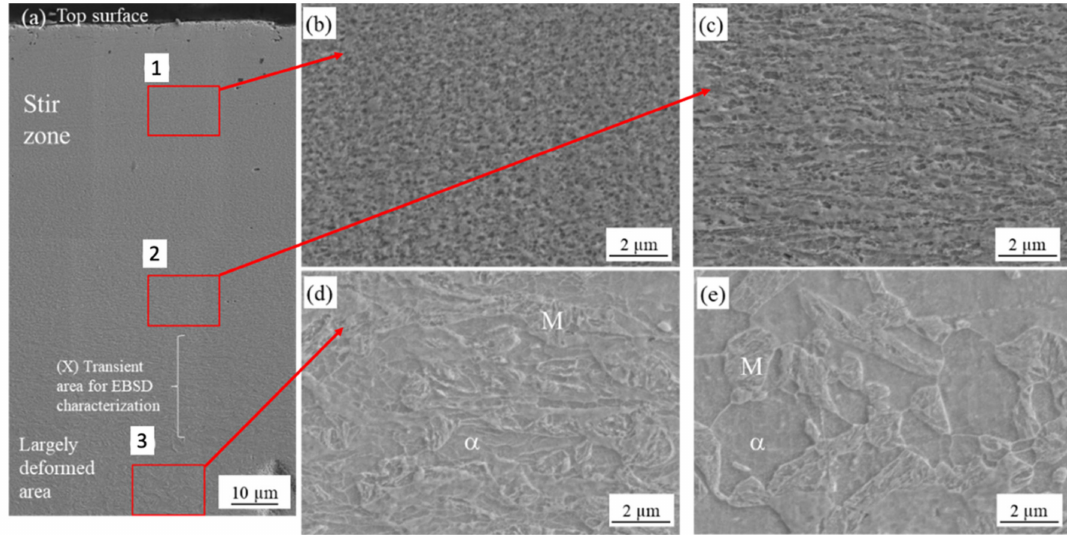
Figure 7. SEM micrographs of the cross-section near the top surface of sample A: ( a ) low-magnified cross-sectional SEM image near the top surface. Red squares mark locations from “1” to “3” are for SZ, transient zone, and deformed zone, respectively; ( b ) magnified SEM image at the SZ indicated as “1,” which consists of very fine-grained microstructures under 0.6 µ m; ( c ) magnified SEM image at transient zone marked as “2,” consisting of small and deformed microstructures; ( d ) magnified SEM image at deformed area marked as “3” where microstructures are largely deformed; and ( e ) area at a distance of 200 µ m away from the top surface, whose microstructures are similar to the